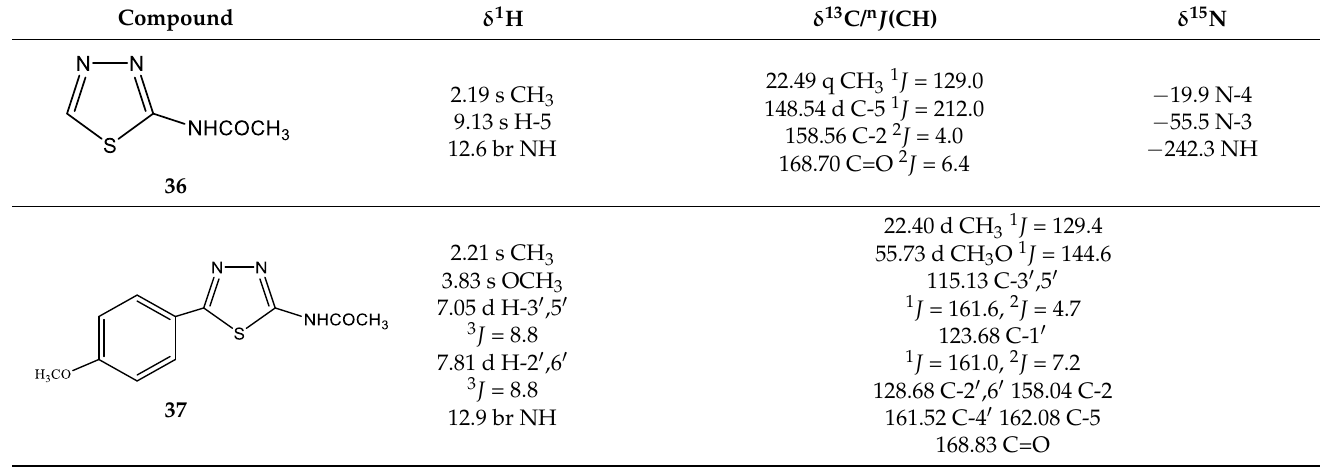
Table 8. Chemical shifts ( δ , ppm) and coupling constant ( J , Hz) in the NMR spectra of 2-acetylamino-1,3,4-thiadiazole ( 36 ), 2-acetylamino-5-aryl (heteryl) -1,3,4-thiadiazoles ( 37 , 38 ) and 2-acetylamino-4-